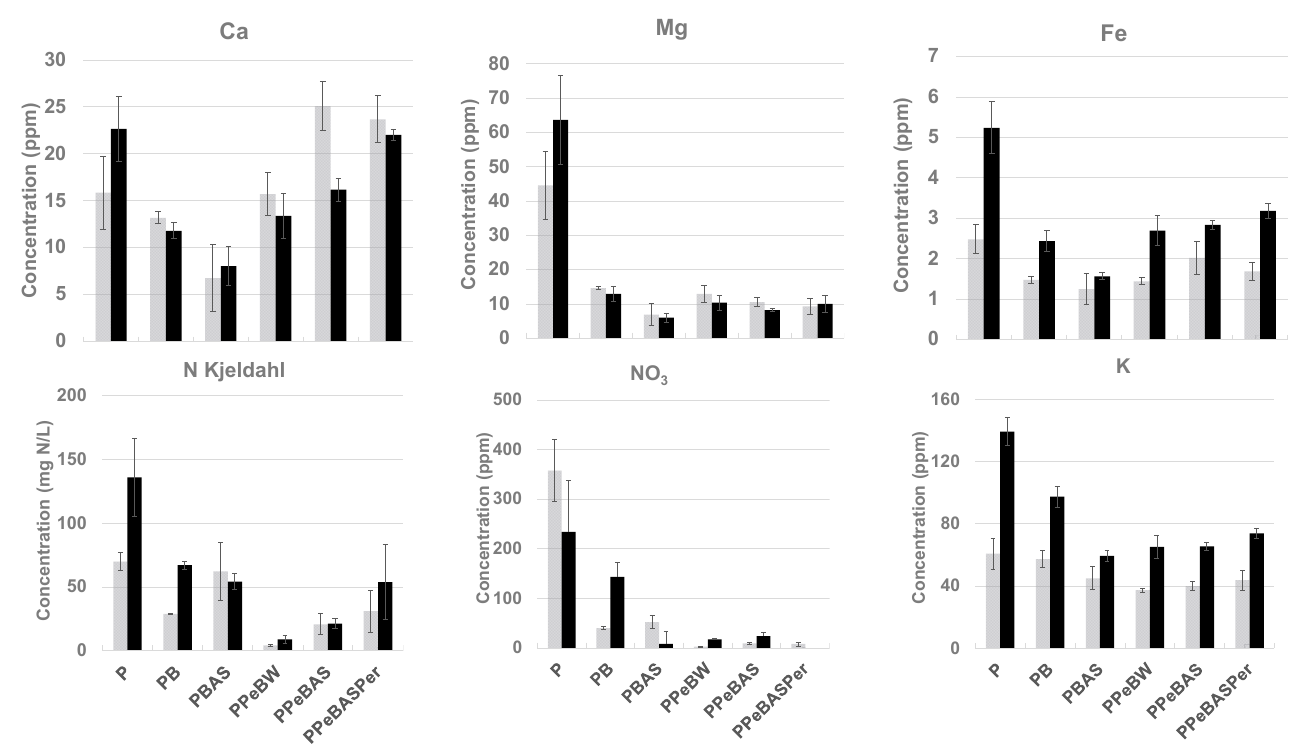
substrates containing pellets showed a lower percentage of potassium and magnesium compared to the control substrate. However, the substrate having biochar and peat (PB) had, in most cases, the same or better proportions of nutrients compared to the control substrate (P). The needles from the treatments with bulk biochar (PB and PBAS) contained slightly more nitrogen compared to the other treatments as seen in Figure 8. Additionally, all the treatments had less K in their needles than the control.